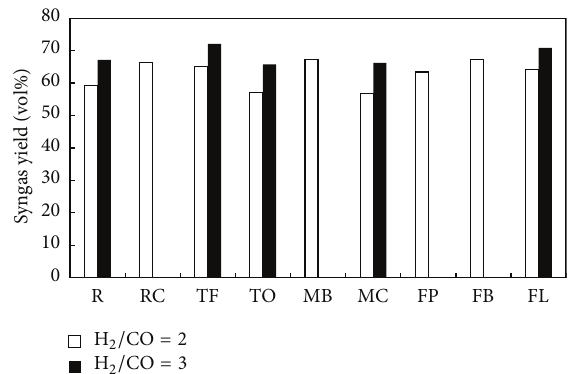
Figure 6: Total yield of syngas at H 2 /CO = 2 and H 2 /CO = 3.